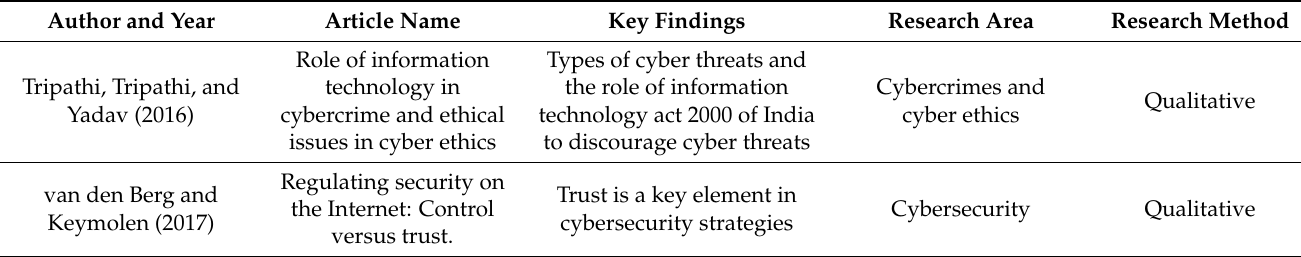
Table A1. Cyber threats on the